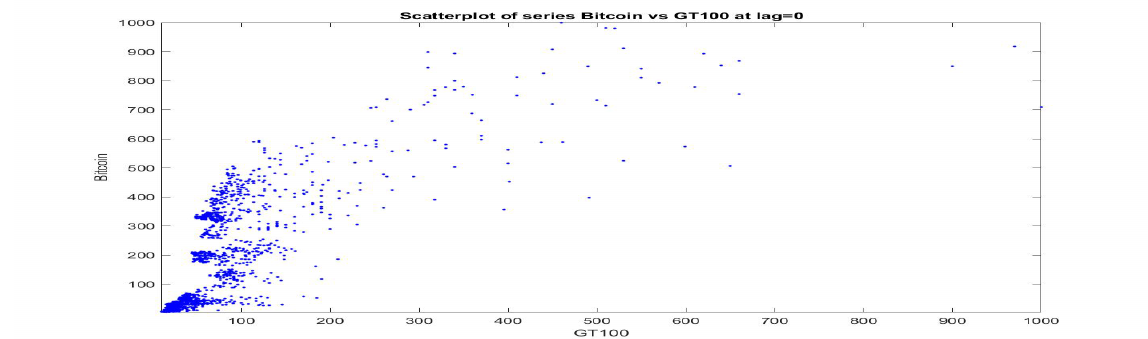
Figure 4. Scatterplot ( GT 100 t , BitCoin t ) of daily Bitcoin prices vs daily GT100 series. For this visualization, the two time series are normalized to the common range [ 0,1000 ]